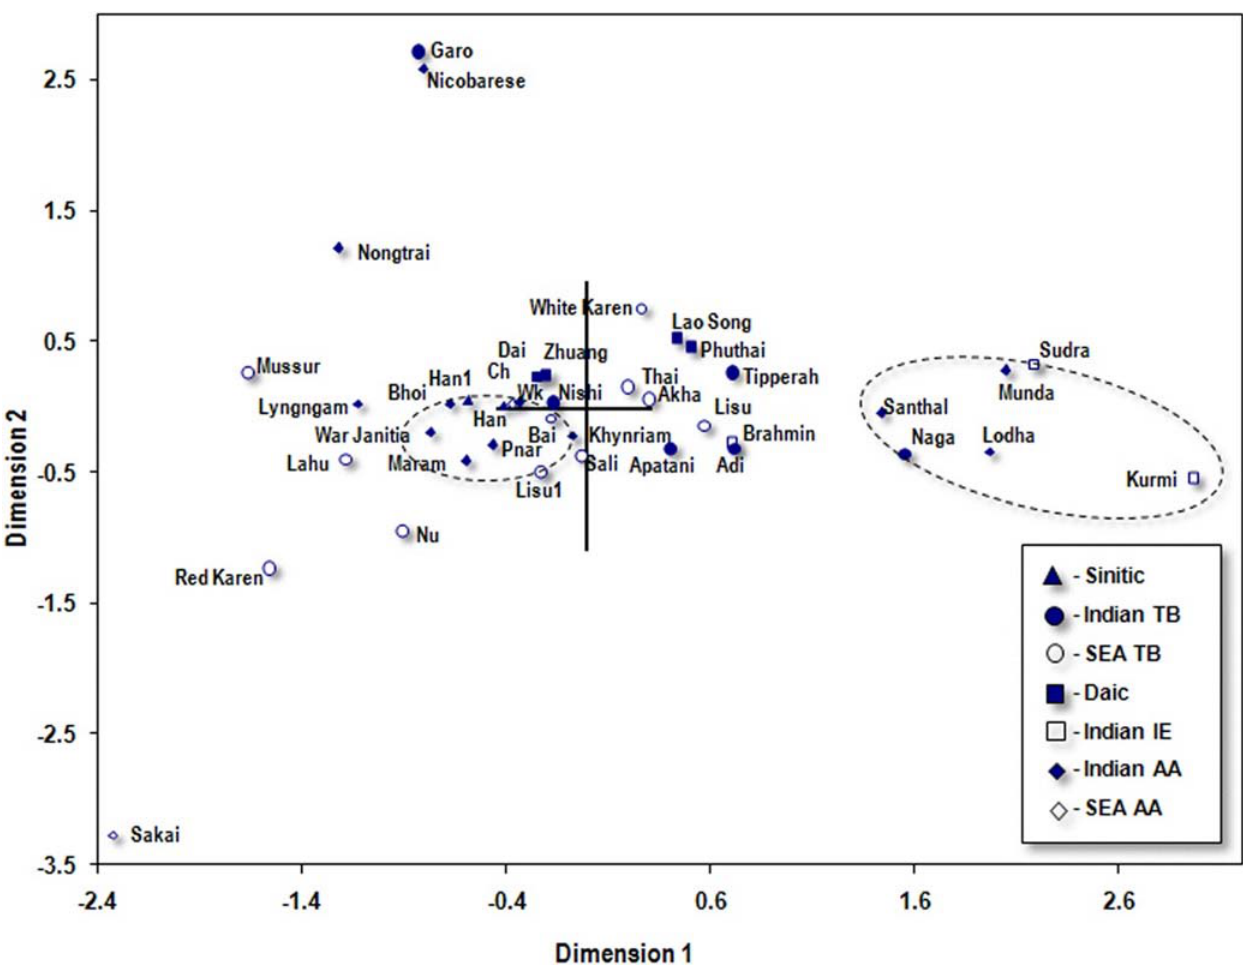
Figure 6. Plot on the first two dimensions derived from the multidimensional scaling of the pairwise F ST distances of the populations based on mtDNA haplogroups. Reference to comparative data is given at Table 6. SEA, Southeast Asian; AA, Austro-Asiatic; IE, Indo-European; TB, Tibeto- Burman; Wk, WarKhasi; Ch, Chong;